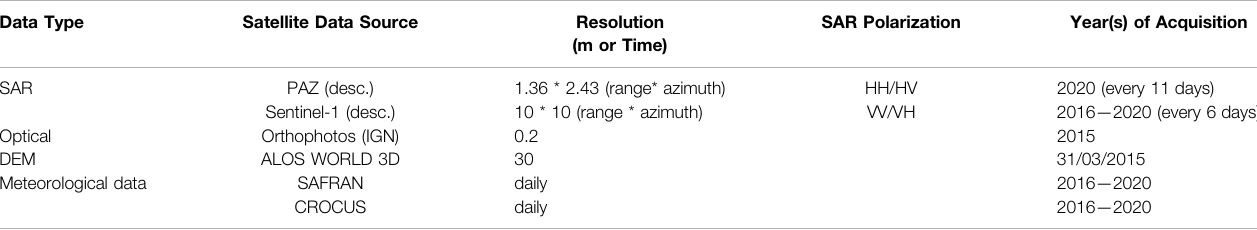
TABLE 1 | Datasets used for the